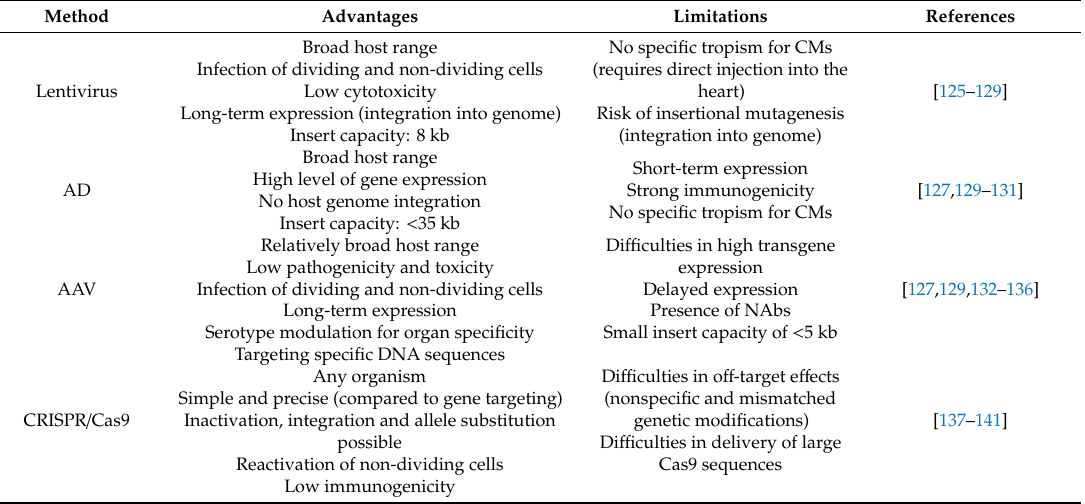
Table 1. Advantages and limitations of di ff erent gene delivery vectors and CRISPR / Cas9